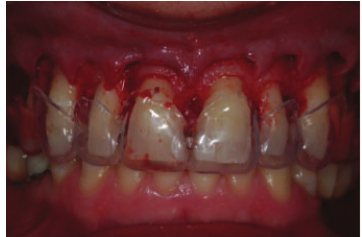
Figure 11: Clinical aspect after the bone removal.